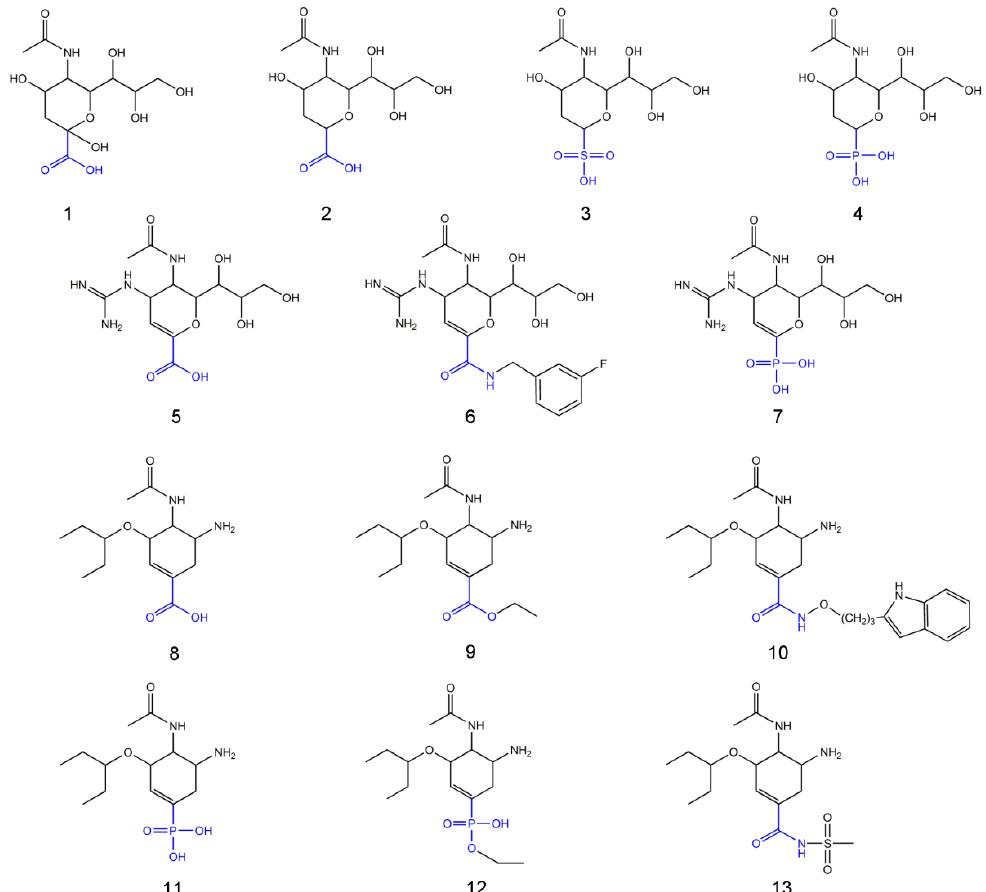
Figure 1. Chemical structures of sialic acid ( 1 ), deoxysialic acid ( 2 ), its sulfonic and phosphonic analogues ( 3 , 4 ), zanamivir ( 5 ), an amide derivative of zanamivir ( 6 ), a phosphonic analogue of zanamivir ( 7 ), oseltamivir carboxylate ( 8 ), oseltamivir ( 9 ), a hydroxamic derivative ( 10 ), a phosphonic analogue of oseltamivir and its ethyl ester ( 11 , 12 ), and an analogue containing a sulfonamide group ( 13 ). The functional group that can interact with the arginine triad is highlighted in blue.